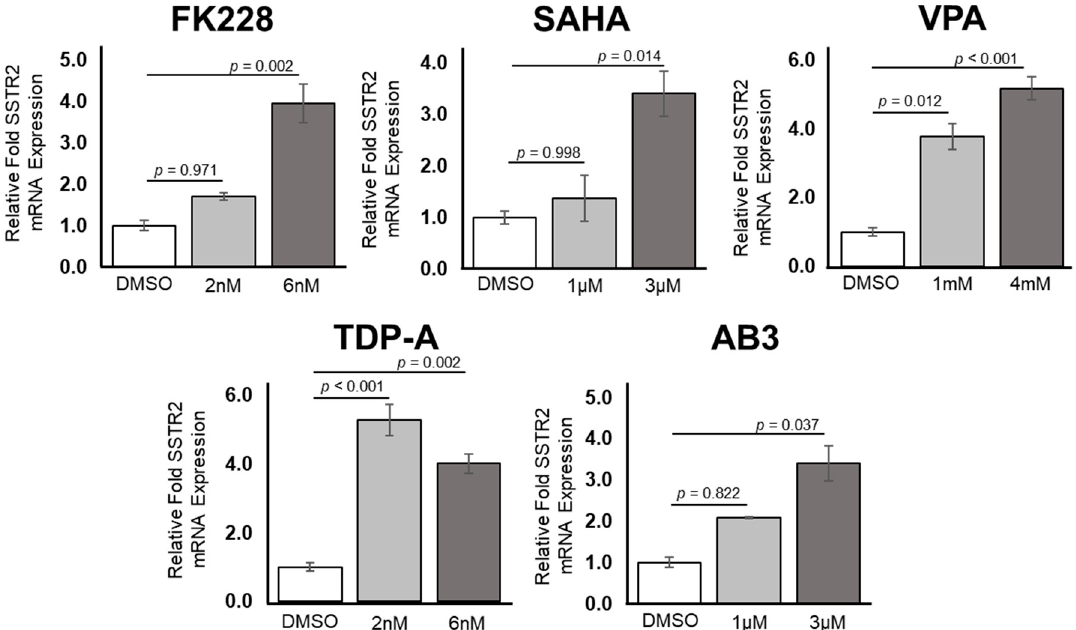
Figure 2. Upregulation of SSTR2 at the transcriptional level in H727, a pulmonary carcinoid cell line. Using two concentrations of five different histone deacetylase (HDAC) inhibitors, there is an increase in SSTR2 mRNA expression. There was a statistically significant increase after treatment with 6 nM romidepsin (FK228), 3 µM suberoylanilide hydroxamic acid (SAHA), 1 mM and 4 mM valproic acid (VPA), 2 nM and 6 nM thailandepsin A (TDP-A) and 3 µM AB3 .